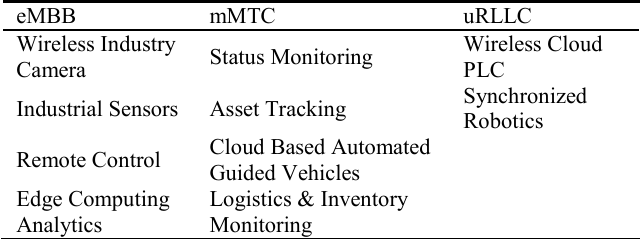
Table 2. Application of 5G in Industry 4.0 across